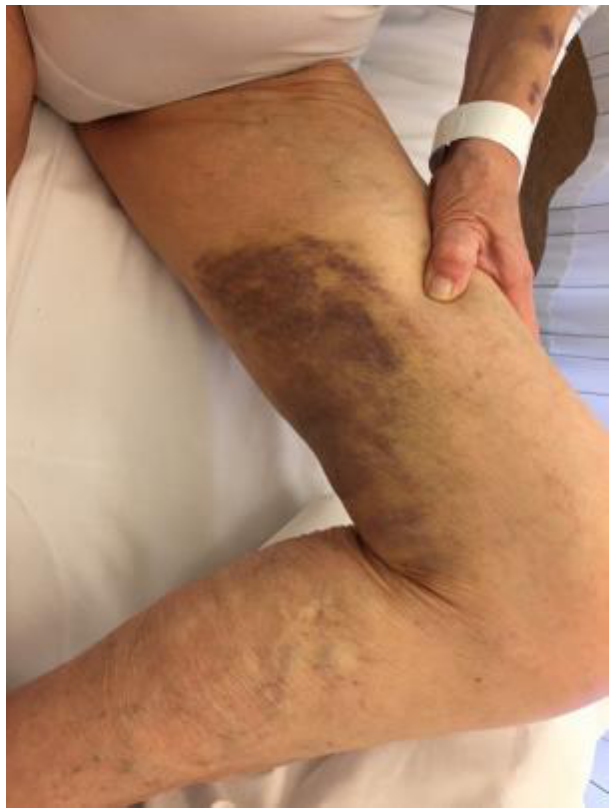
Figure 5. Extensive hematoma on the left upper leg.